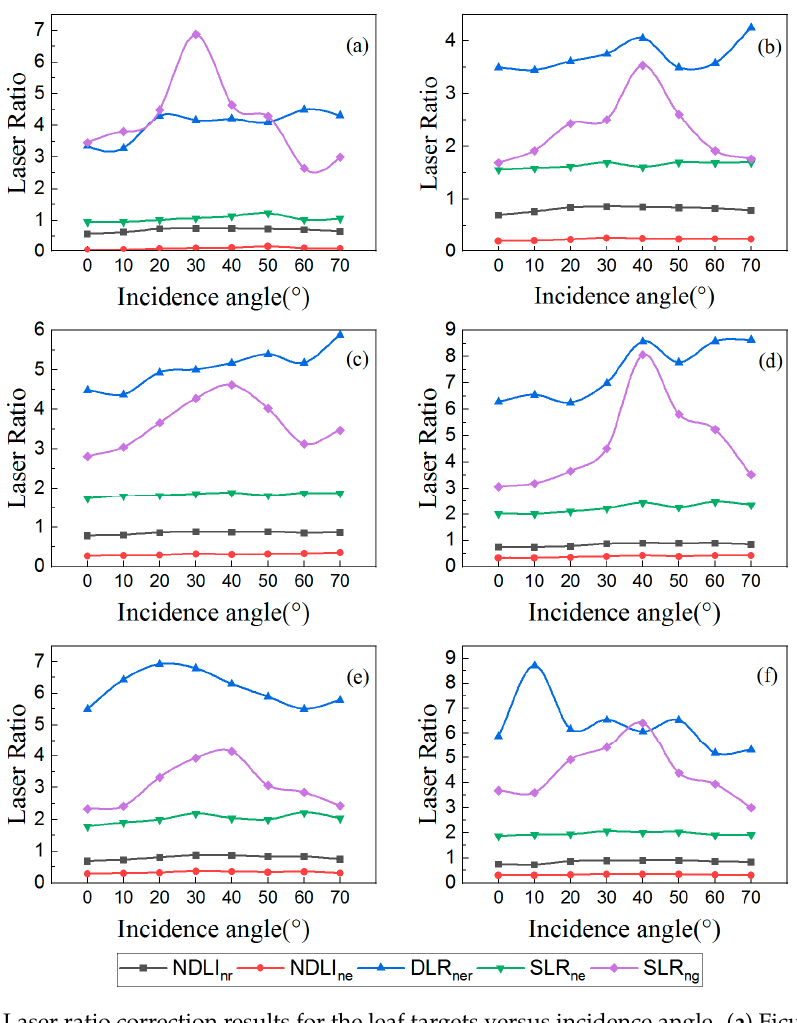
Figure 11. Laser ratio correction results for the leaf targets versus incidence angle. ( a ) Ficus elastica, ( b ) Epipremnum aureum, ( c ) Aglaonema modestum, ( d ) Hibiscus rosa-sinensis Linn, ( e ) Spathiphyllum kochii and ( f ) Kalanchoe blossfeldiana Poelln.